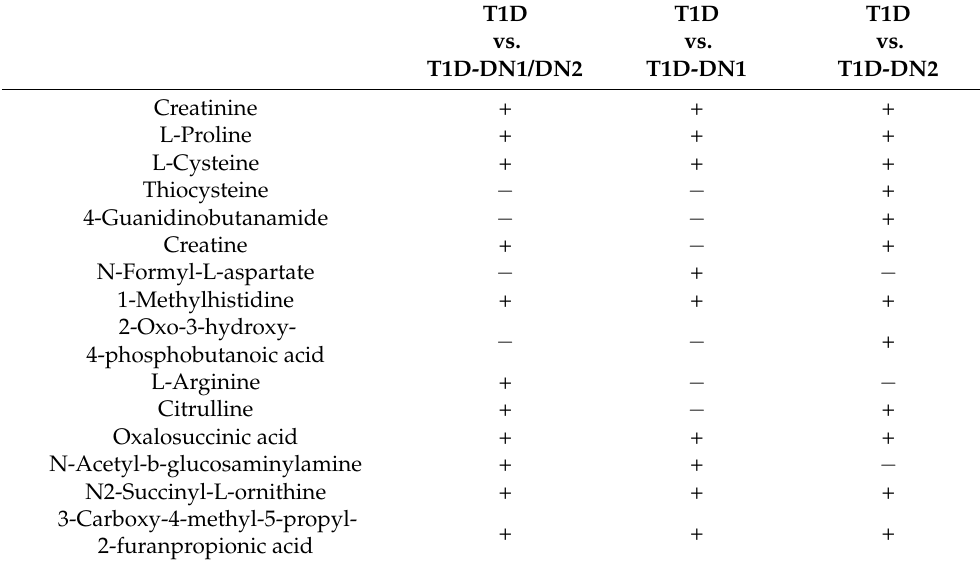
Table 3. The best combinations of metabolites for diagnosing DN cases in the patients with T1D.